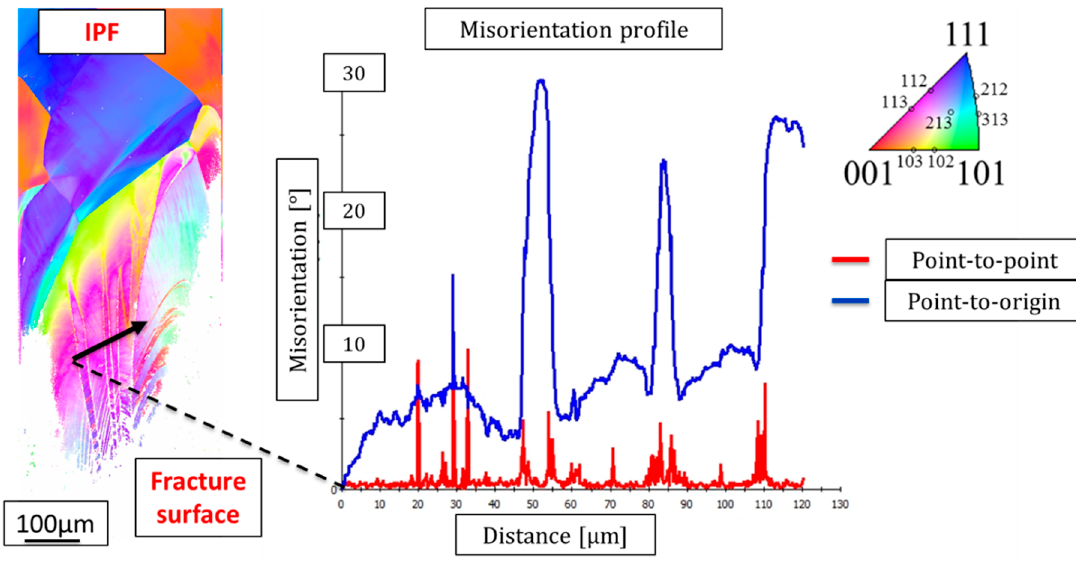
Figure 9. ( a ) Inverse pole figure mapping (magnification ( c )) and ( b ) image quality mapping with grain boundaries of a broken solution annealed oligo-crystalline wire (magnification ( d )).